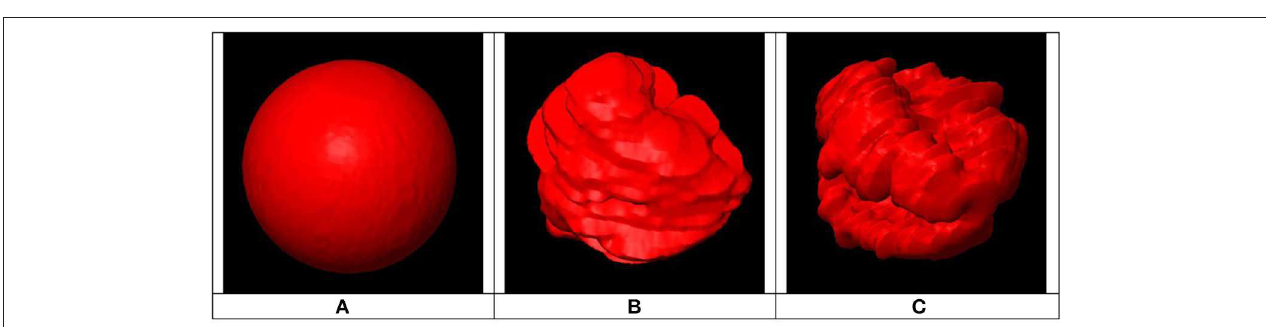
FIGURE 4 | Example of three PTVs with same volumes, different surface areas and different regularity indices: (A) Smallest surface area (RI = 1) associated with highly regular shape, (B) Medium shape regularity (RI < 1), (C) Largest surface area (RI << 1) associated with highly irregular shape.